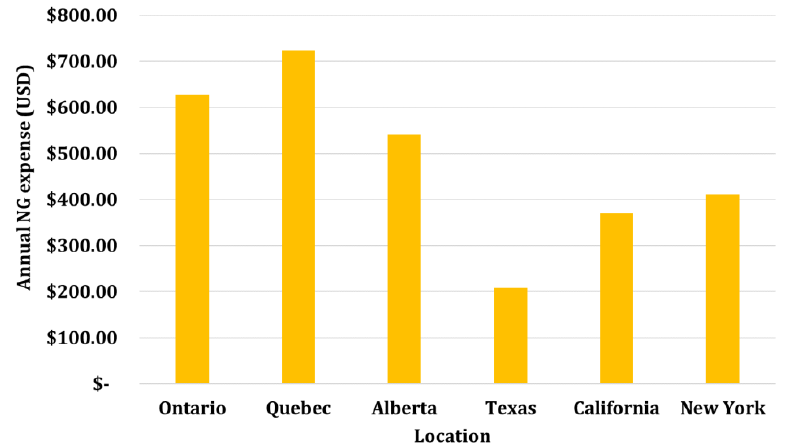
Figure 25. Annual natural gas expense in six North American locations to heat Greenhouse 1.